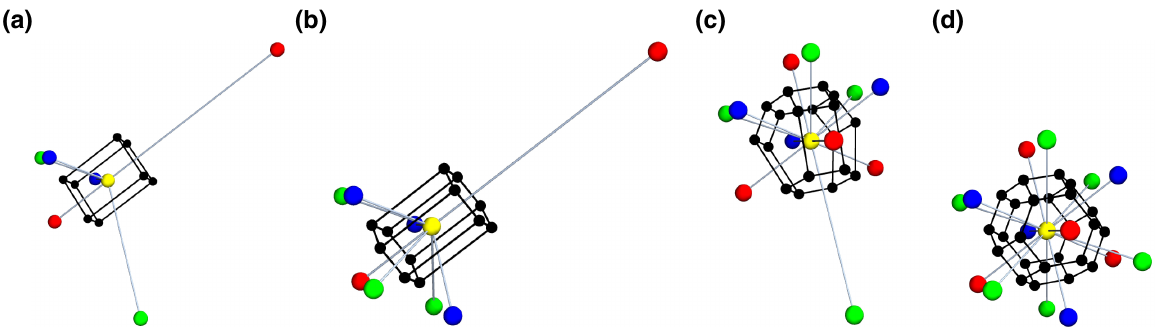
FIG. 38. Dual and primal lattices for the 2D spherical color codes, which appear in the preparation of interior of the 3D color code. Qubits are black dots, and stabilizers are gray edges with colored vertices. For each, the subset of vertices from v list in Eq. (D1) are (a) { 1, 2, 3, 4, 8, 15, 17 } , (b) { 1, 2, 3, 4, 6, 7, 8, 11, 17 } , (c) { 1, 2, 3, 4, 5, 8, 9, 10, 12, 13, 14, 15 } , and (d)